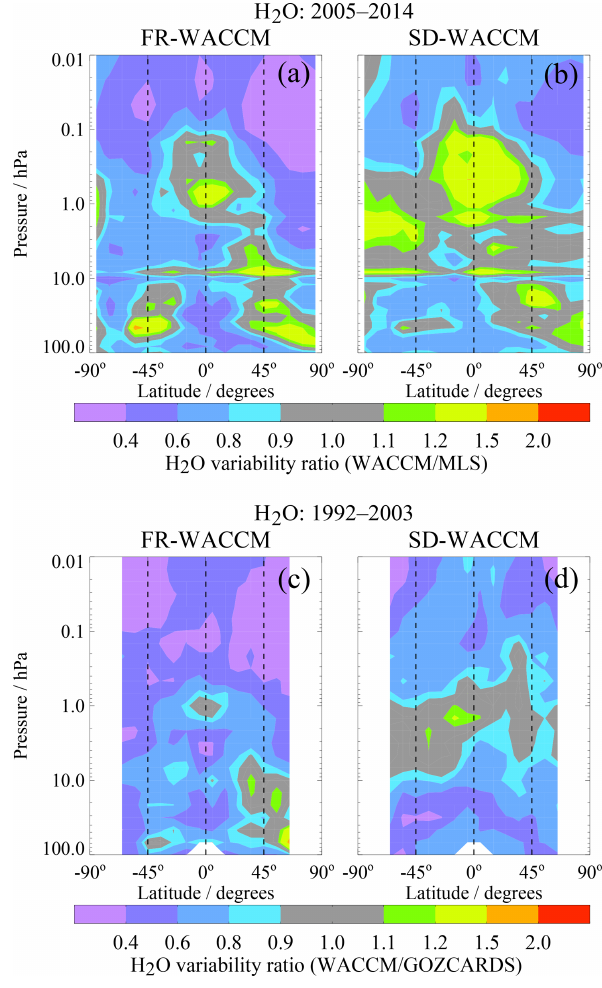
Figure 15. Same as Fig. 14 but for ratios (model/data) of H 2 O stratospheric and mesospheric variability for two different time pe-